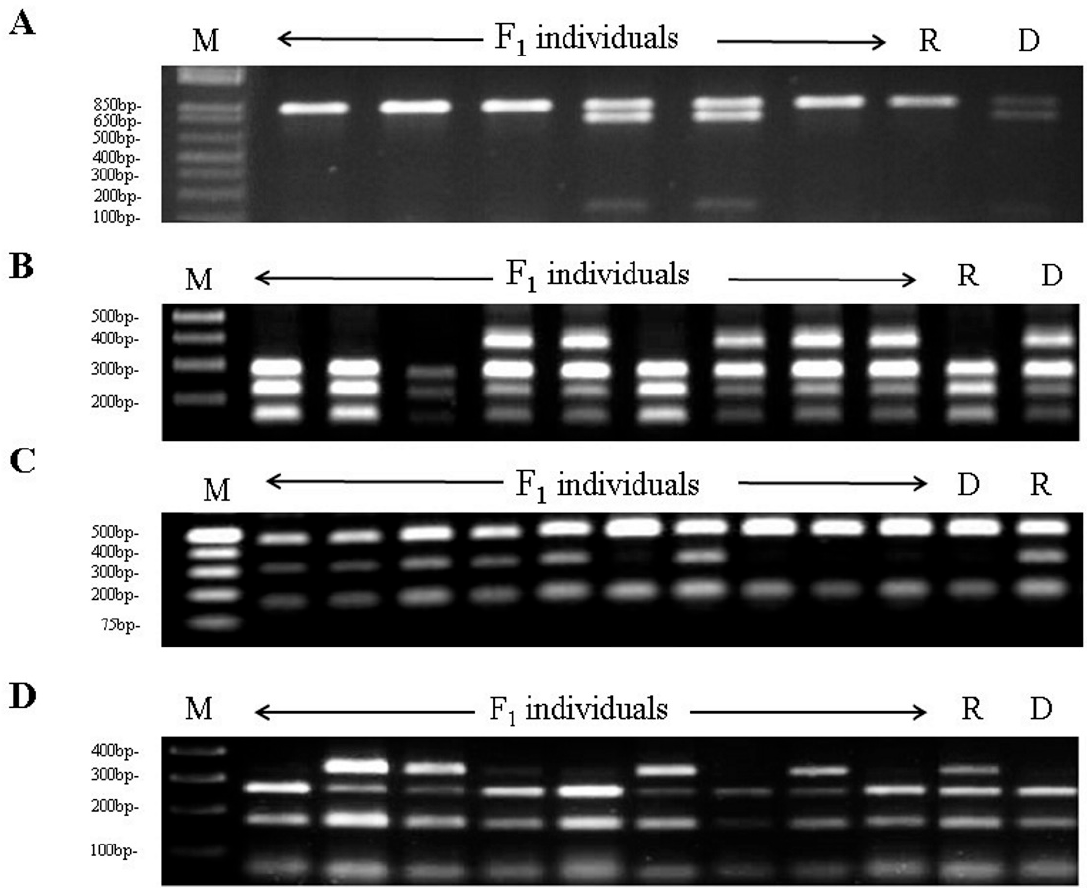
Figure 1. Agarose gel electrophoresis of cleaved amplified polymorphic sequence (CAPS) markers on the two parental genotypes R1000 (R) and Desmayo Largueta (D) and segregating F 1 individuals. The panels ( A ), ( B ), ( C ), and ( D ) refer to the markers ppa001838m/ Msp I, ppa006282m/ HpyCH4 V, ppa027182m/ Hpy188 I, and ppa018792m/ Alu I, respectively.